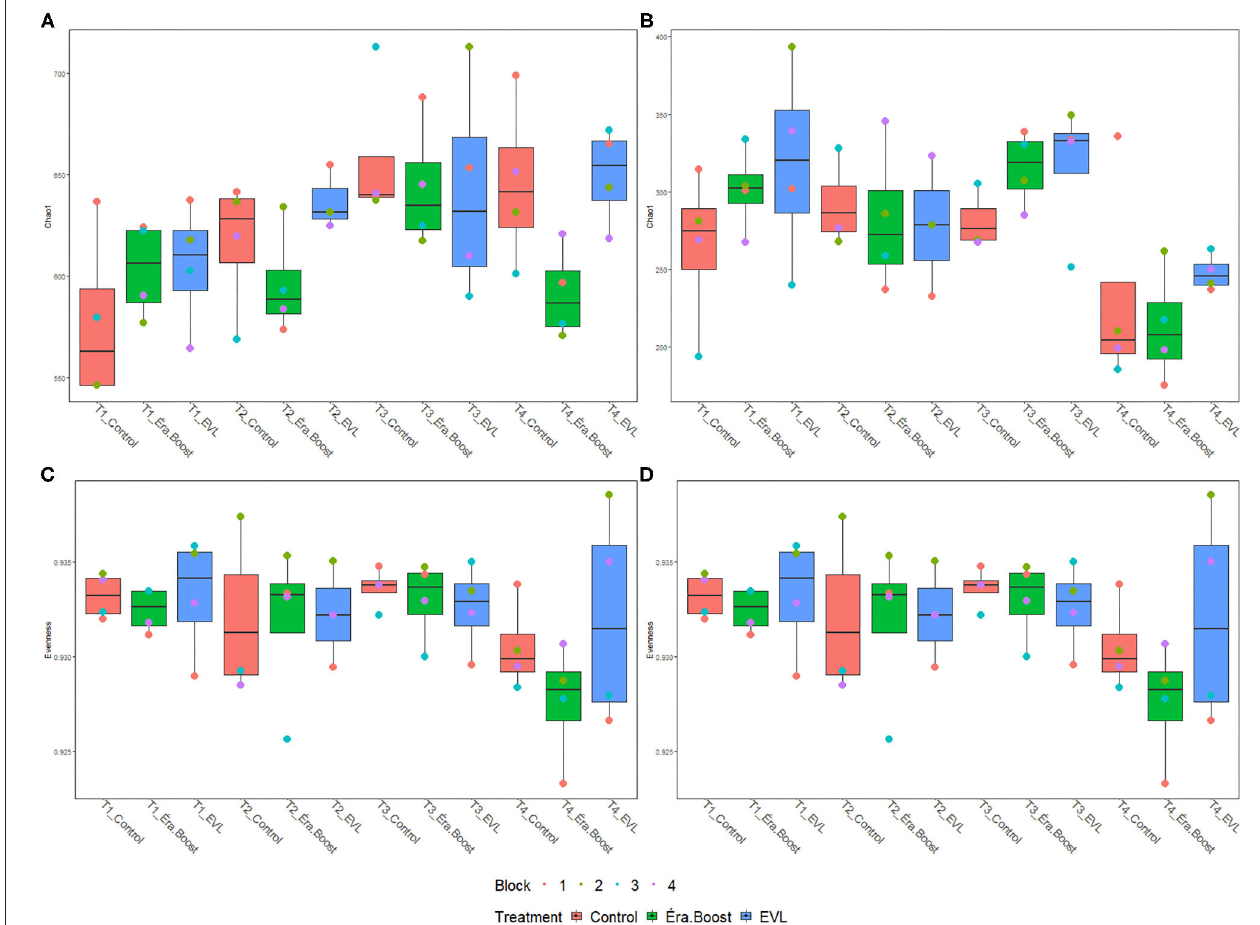
FIGURE 2 | Boxplots of Chao1 and evenness measurements for bulk soil samples. (A,B) Display Chao1 values for prokaryotic and fungal communities, respectively, while (C,D) display evenness values for prokaryotic and fungal communities, respectively; T1: May 27th, T2: June 7th, T3: June 21st, T4: July